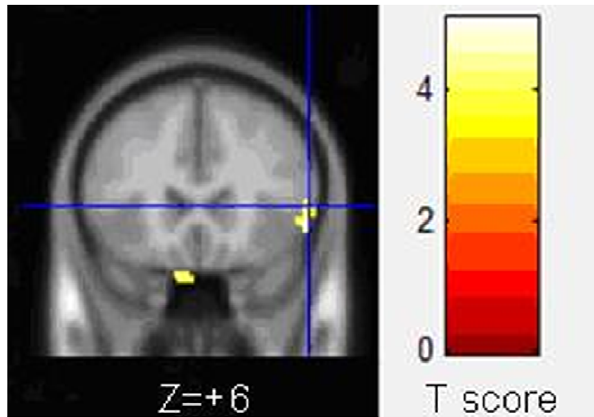
Figure 3. White matter region with increased FA in adult strabismus. White matter region with higher FA in strabismus patients was found in the right inferior frontal gyrus (Z= + 6).